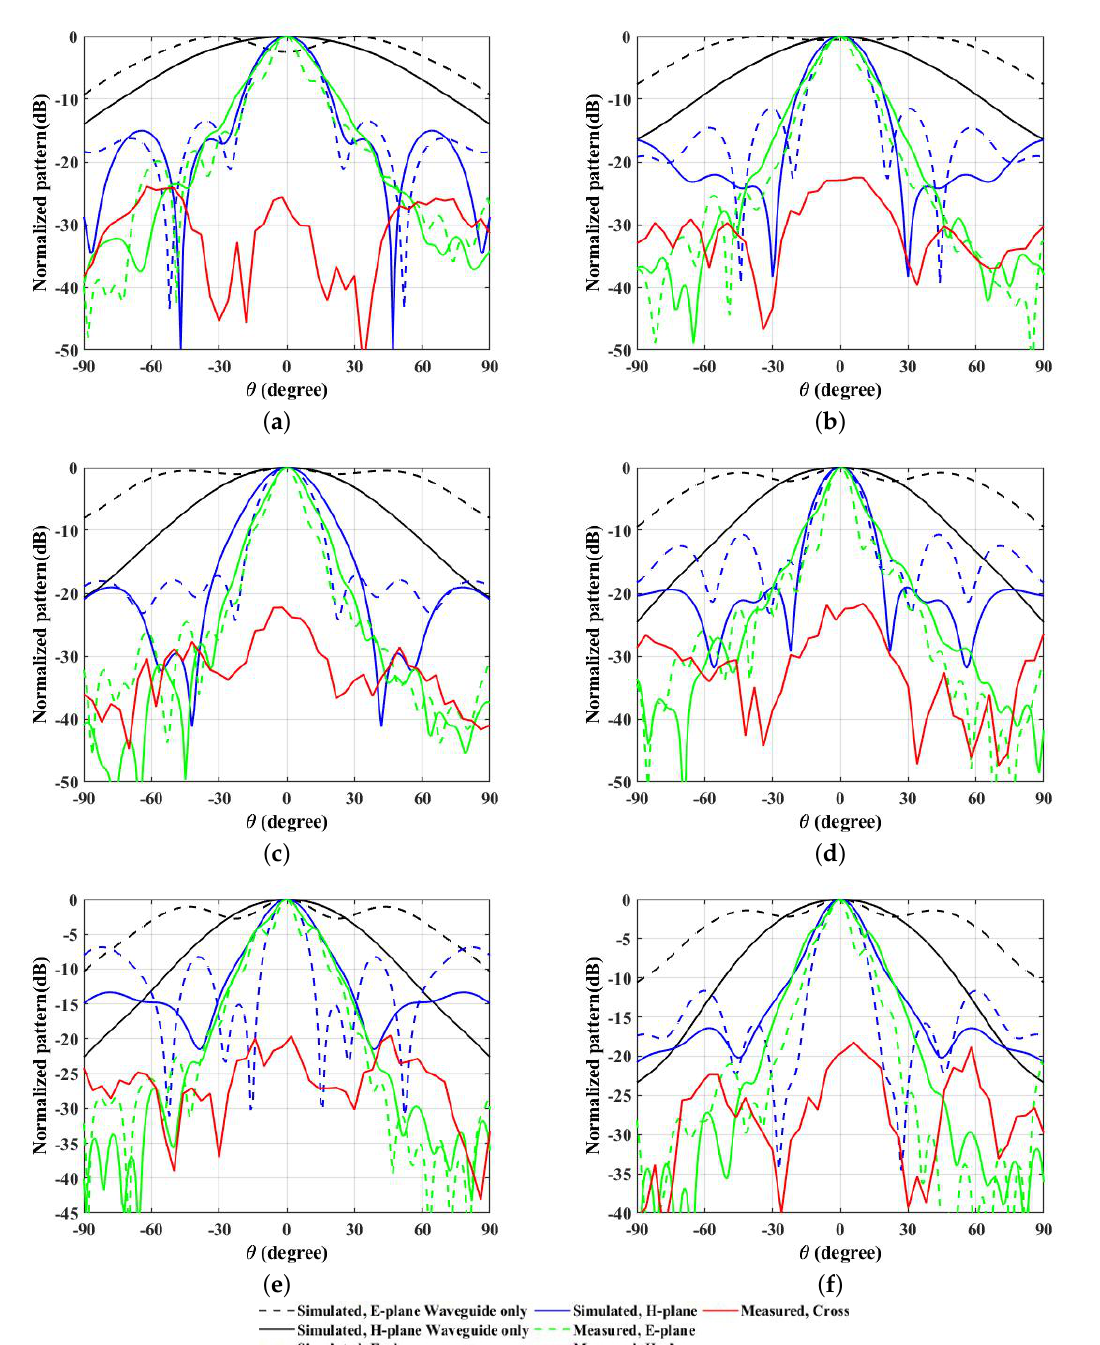
Figure 10. Simulated and measured radiation patterns as observed with the use of the PREPERM 10 designed surface, which is shown in ( a – f ) for 10 GHz, 11, GHz, 12 GHz, 13 GHz, 14 GHz, and 15 GHz